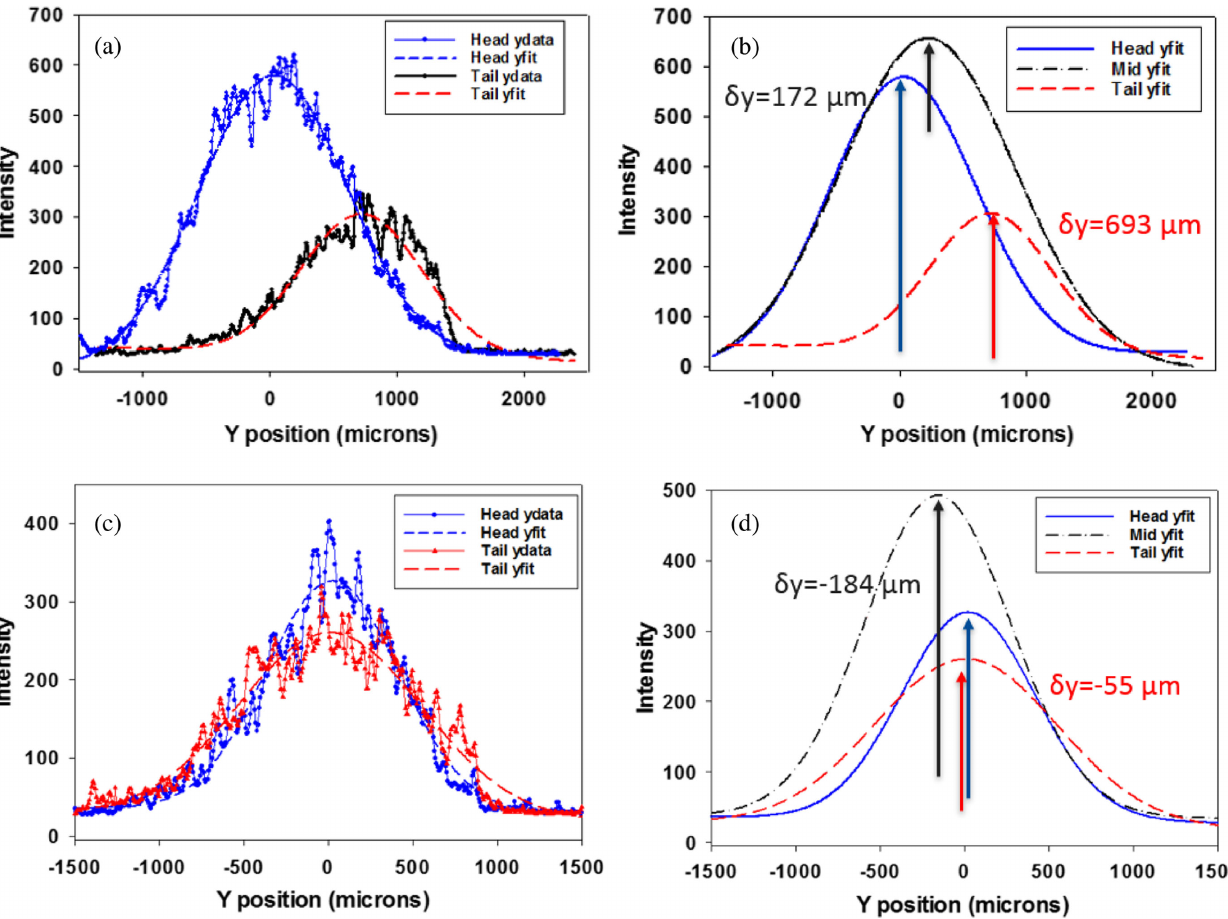
FIG. 6. (a) Transverse profiles from the head and tail of the image with V 103 ¼ þ 2 . 4 A (5 mrad). (b) Gaussian fits to the transverse profiles taken at the head, middle, and tail of the longitudinal distribution. Head-to-middle and head-to-tail centroid shifts, δ y ¼ þ 172 and þ 693 μ m, respectively, were observed. (c) Transverse profiles from the head of the image (blue curve) with a Gaussian fit (blue short-dashed curve) and from the tail of the image (red curve) with a Gaussian fit (red dashed curve) to it for the V 103 ¼ − 2 . 4 A ( − 5 mrad) case. (d) Gaussian fits to the transverse profiles taken at the head, middle, and tail of the longitudinal distribution. A head-to- tail centroid shift of only δ y ¼ − 55 μ m was observed for this